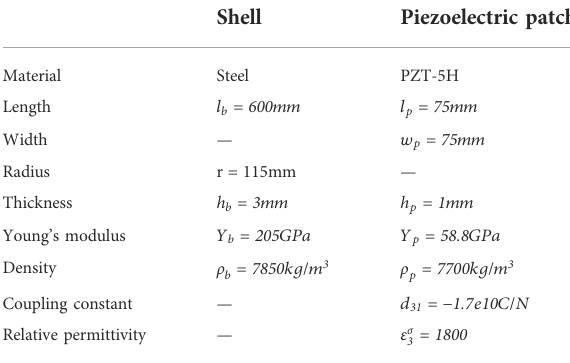
TABLE 1 Material and geometry parameters of the meta-shell.